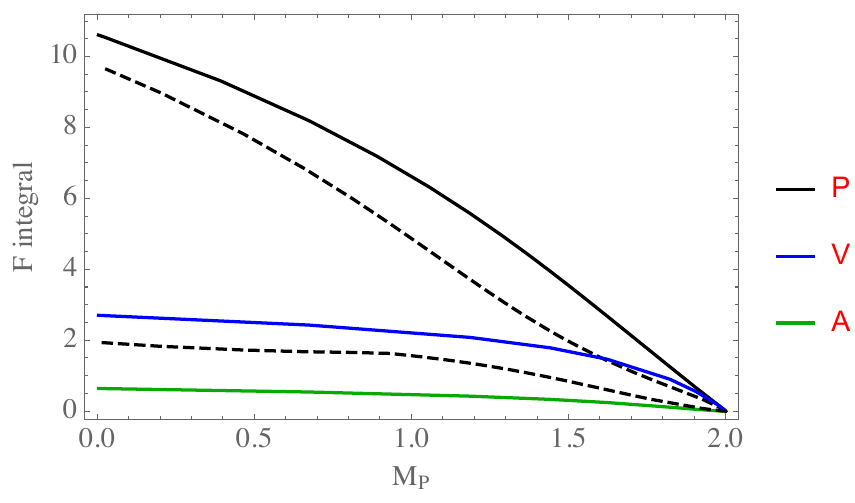
Figure 8 . The integrals appearing in equations (2.8), (2.9), (2.10) for the P , V and A decay constants with m tot = 1. The upper and lower dotted lines are the spin 0 and spin 1 results when the kernel K ( p; q ; 0) is used while also setting m = 0 in the